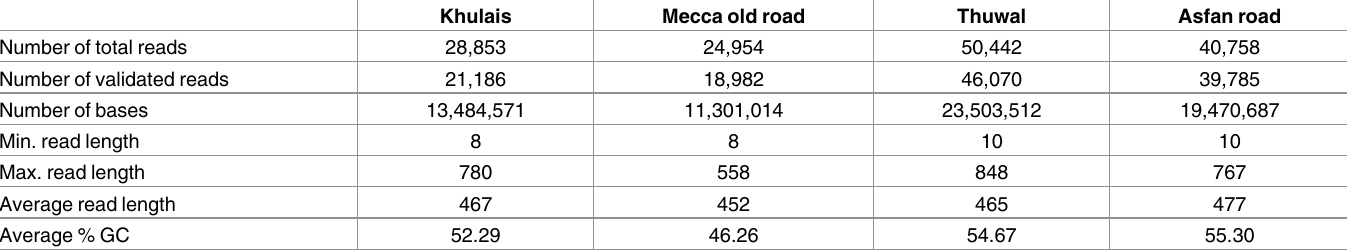
Table 2. Overview of the raw sequencing